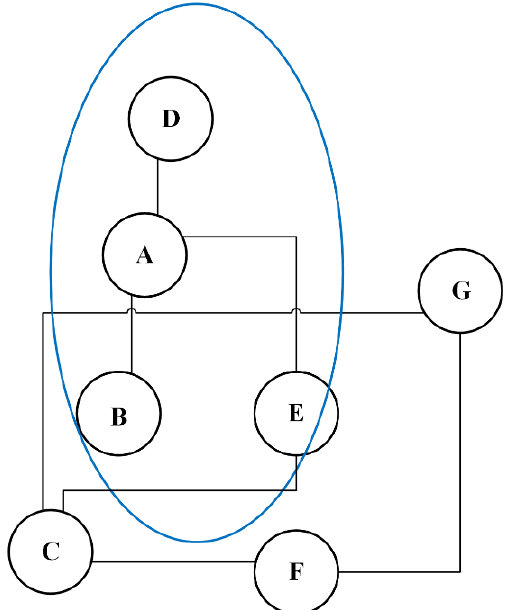
Figure 6. A’s close contact individuals are B, D, and E.